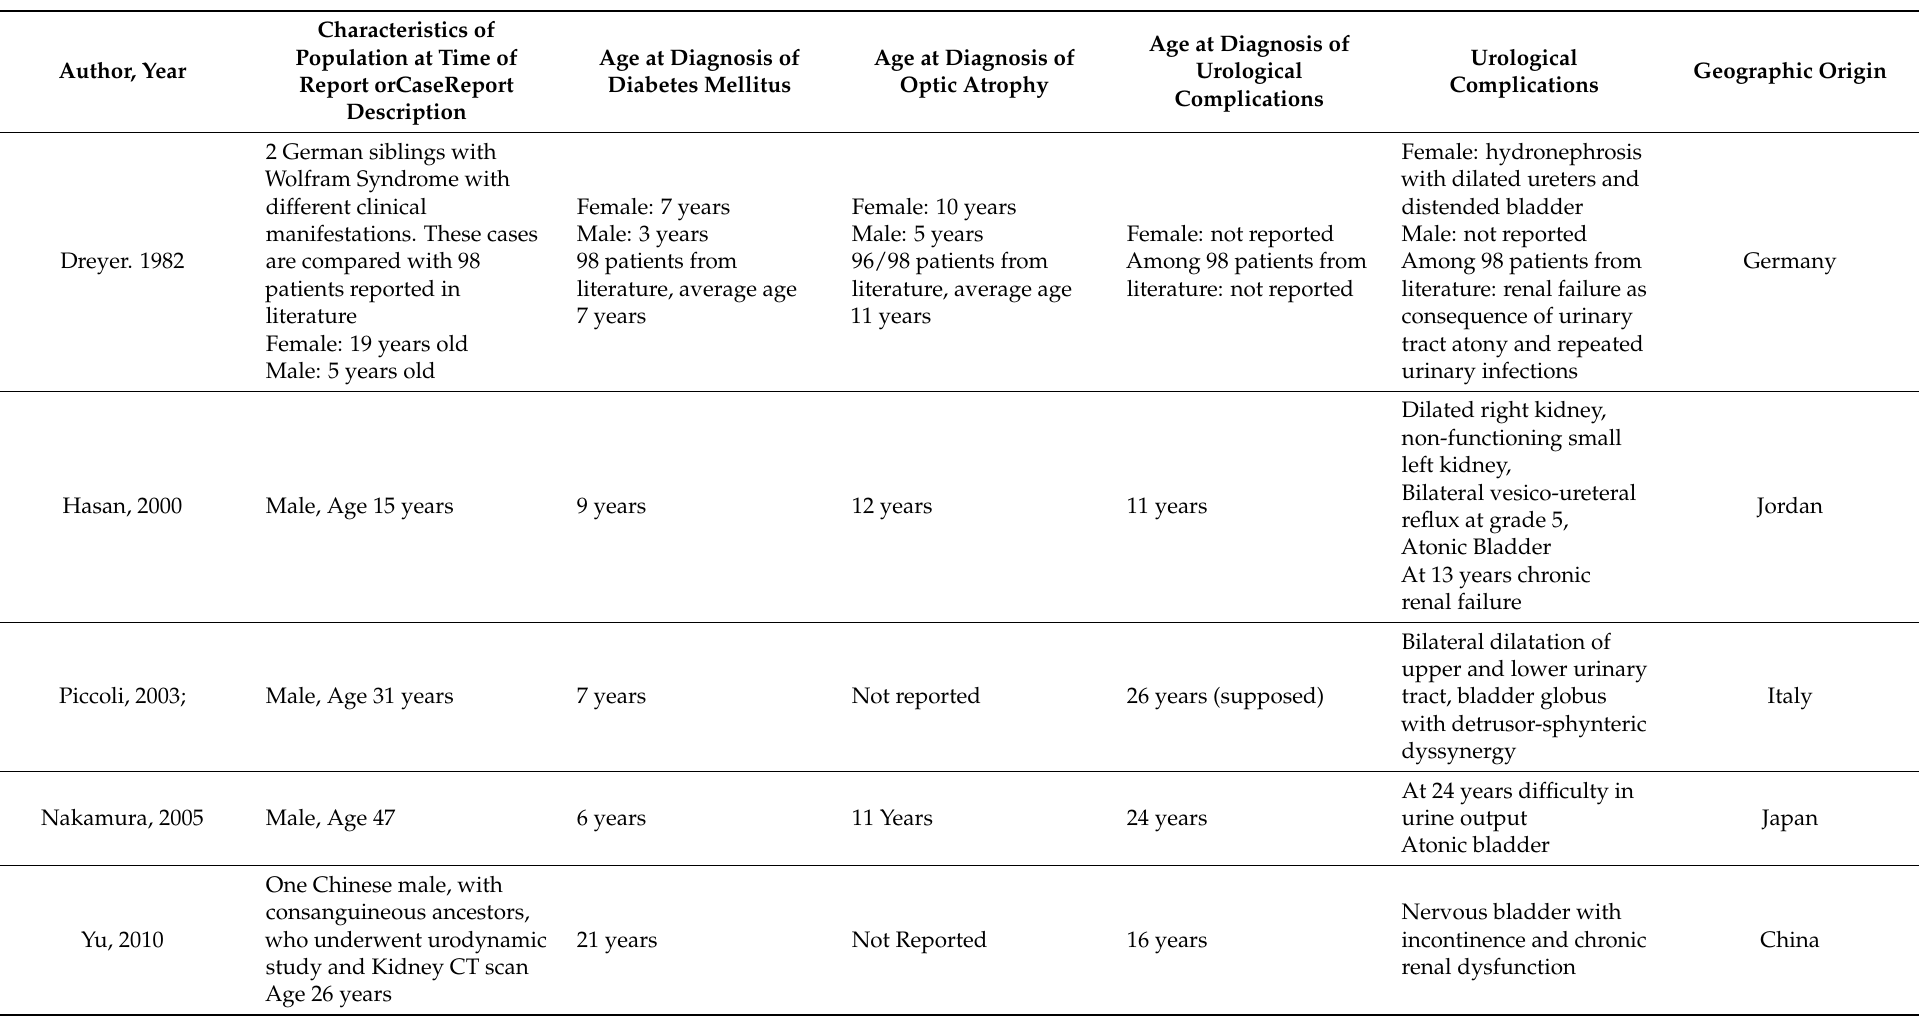
Table 2. Overview of the case reports on renal and urologic involvement in Wolfram